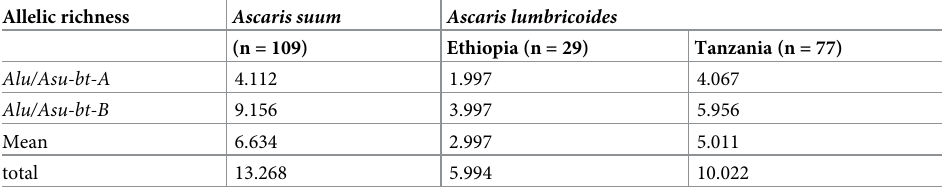
Allelic richness for both Alu/Asu-bt- A and Alu/Asu-bt-B in each of the three populations ( Ascaris suum in Belgium and Ascaris lumbricoides in Ethiopia and Tanzania). Results were calculated using the R package PopGenReport [65,66].